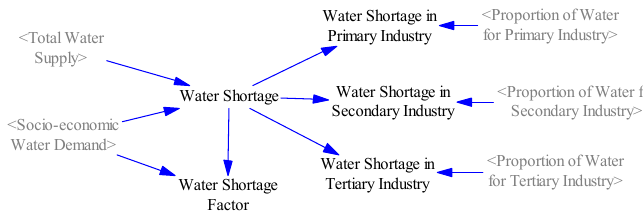
Figure 5. System dynamics flowchart of the water resource shortage subsystem.